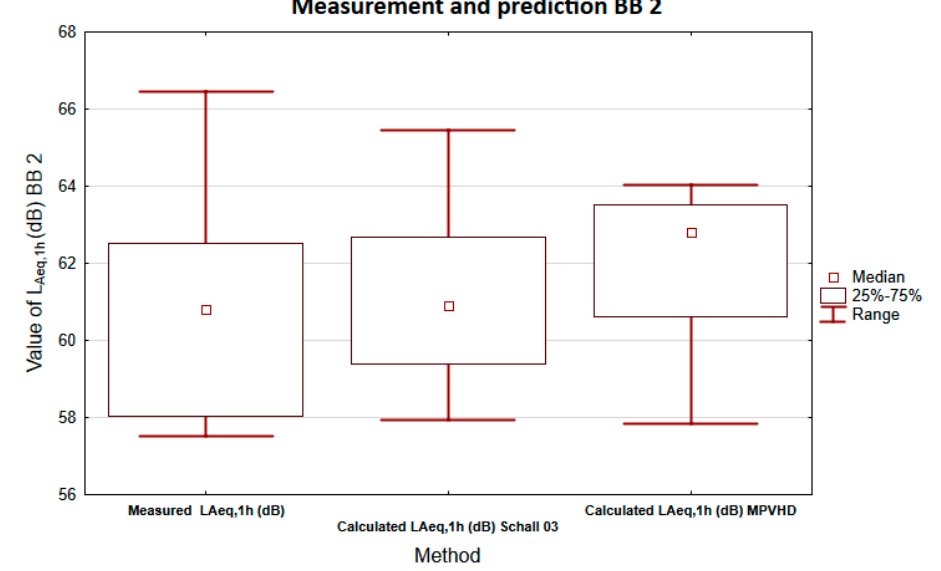
Figure 8. Comparison of equivalent sound pressure levels A using box graphs BB1.